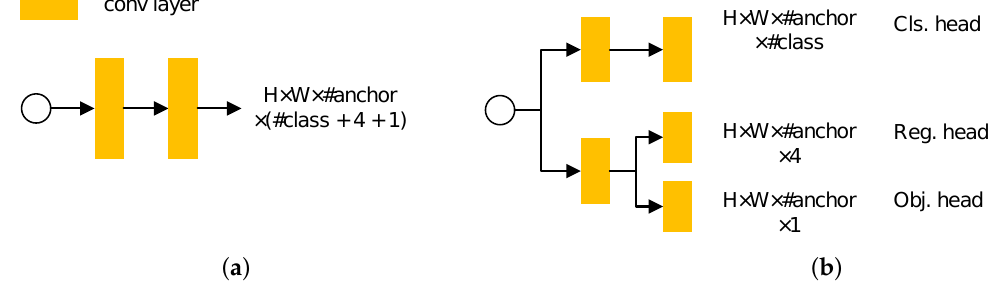
Figure 4. The schematic diagram for the decoupled head in detection. The decoupled head deals with the classification and localization by separated network structures. ( a ) Coupled head. ( b ) Decoupled